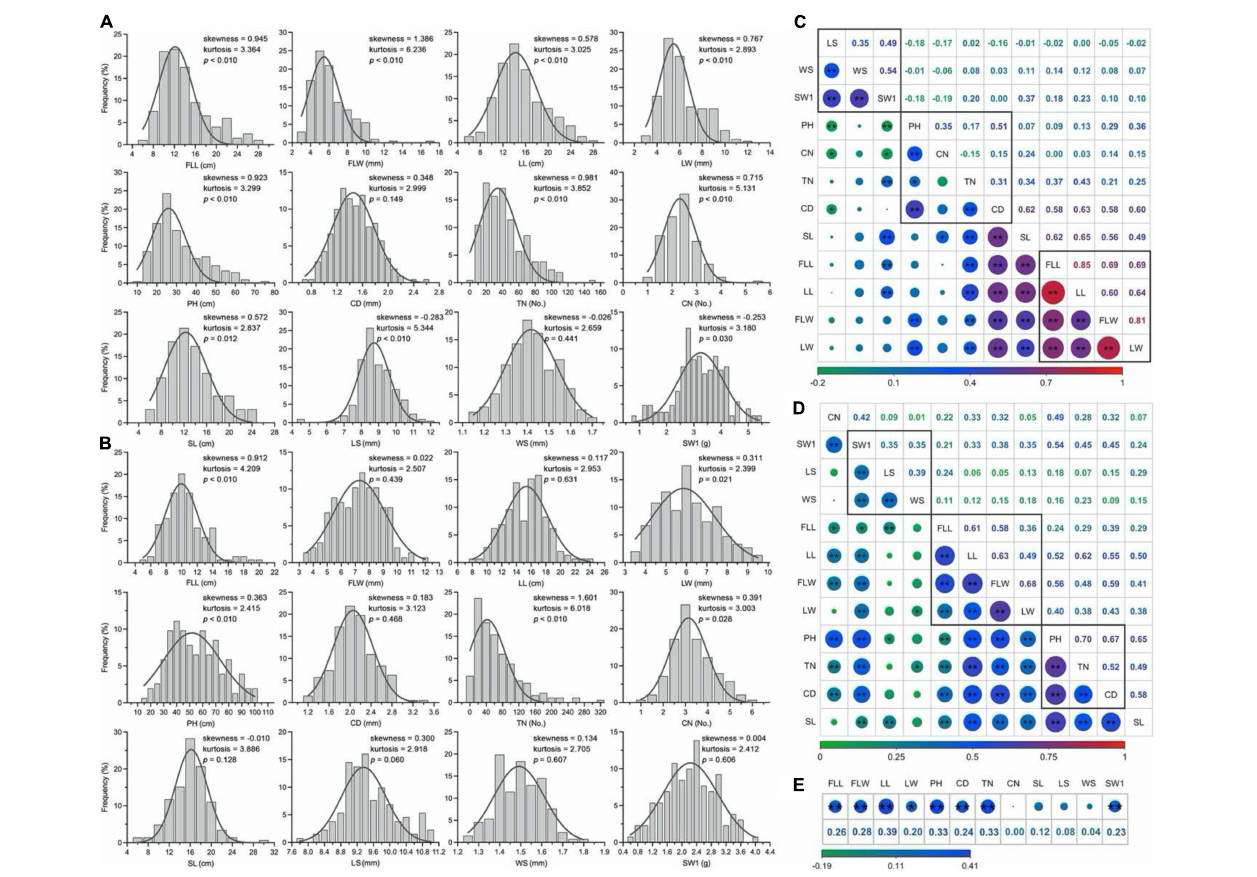
FIGURE 4 | Distribution of phenotypic traits and correlation analysis in E. sibiricus . (A,B) Frequency distribution of the mean values of twelve phenotypic traits in 2 years. (C,D) Pair-wise Person correlations among different traits. The red to green color represents highly positive to highly negative correlations, and the number represents (upper diagonal) the correlation values. The lines in the square indicate the leaf-, culm-, and seed-related traits. Two (**) and single stars (*) indicate significance at 0.01 and 0.05, respectively. (E) Correlation analysis of twelve phenotypic traits between 2